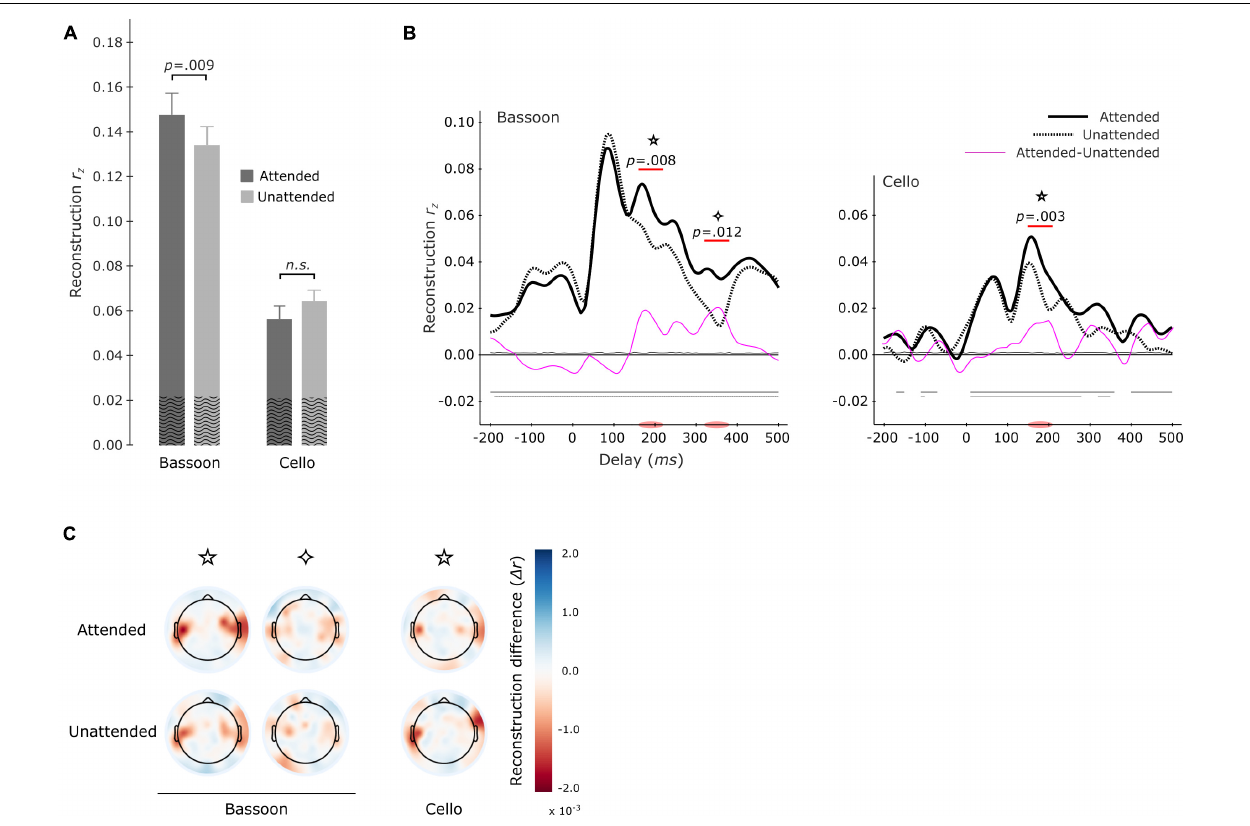
FIGURE 5 | Envelope tracking during the segregation tasks per instrument. Multi-delay model tracking performance (A) for attended (dark gray) and unattended (light gray) instruments. The tracking of bassoon and cello envelopes is displayed at left and right two bars, respectively. Horizontal lines and values above denote results of significance testing between attended and unattended conditions for the bassoon and an interaction between attended and reconstructed instrument. The average empirical chance-level is superimposed as black waves. Single-delay tracking profiles (B) for the bassoon envelope (left panel) and cello envelope (right panel). Significant tracking differences between attended and unattended instruments are indicated by the purple lines. Attention effects for bassoon tracking were found during the 160–220 ms ( (cid:73) ) and 320–380 ms ( (cid:71) ) delay windows and for cello tracking only during a 150–210 ms delay window ( (cid:73) ). Differences between attended and unattended tracking are presented as thin pink lines. Thin horizontal lines within the plot indicate the average empirical chance-level. Horizontal lines in the negative indicate time-points which significantly differed from chance. Topographical representation (C) of tracking differences for the leave-one-electrode out analysis of both the attended and unattended conditions for each instrument during the significant delay-windows indicated in panel (B) .